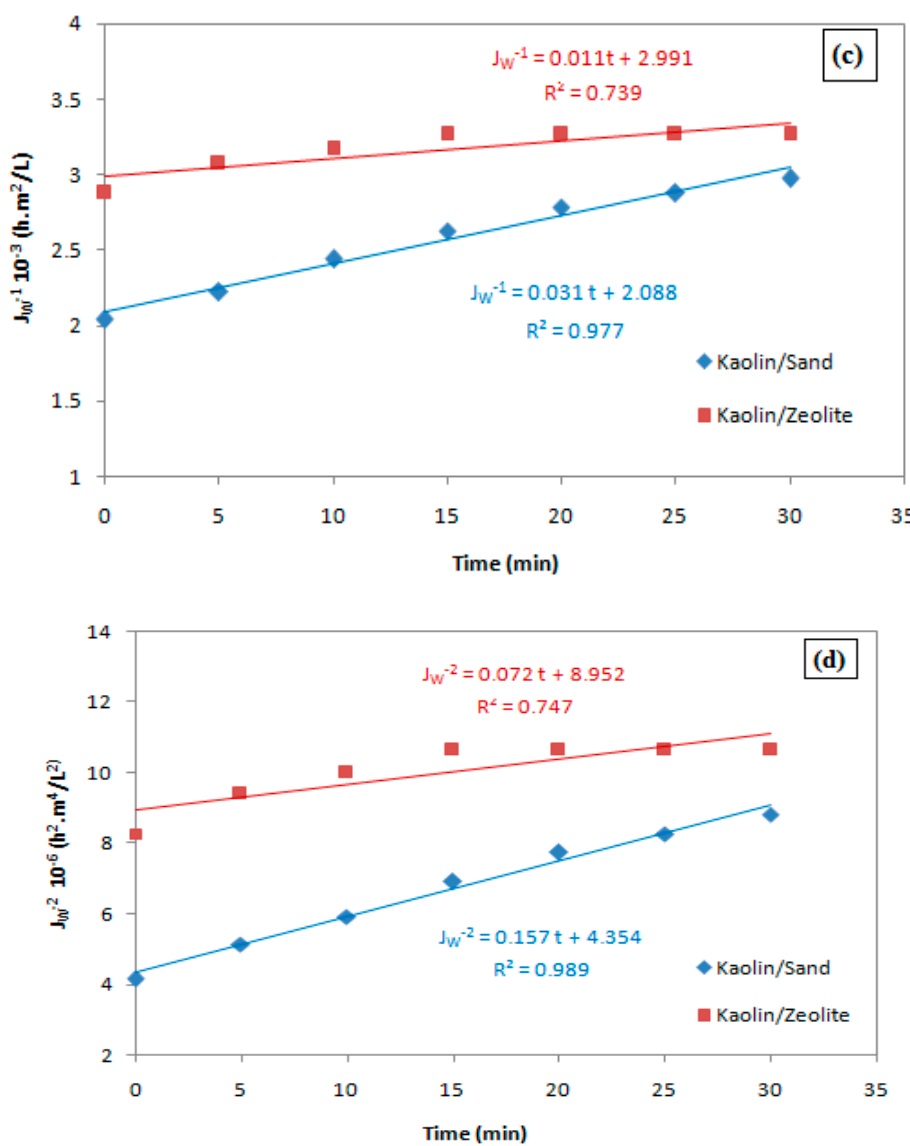
Figure 8. Linearized models of permeate fluxes of wastewater using kaolin membranes: complete pore blocking ( a ), standard pore blocking ( b ), intermediate pore blocking ( c ) and cake filtration ( d ). Table 3. Parameters associated with various pore blocking models.